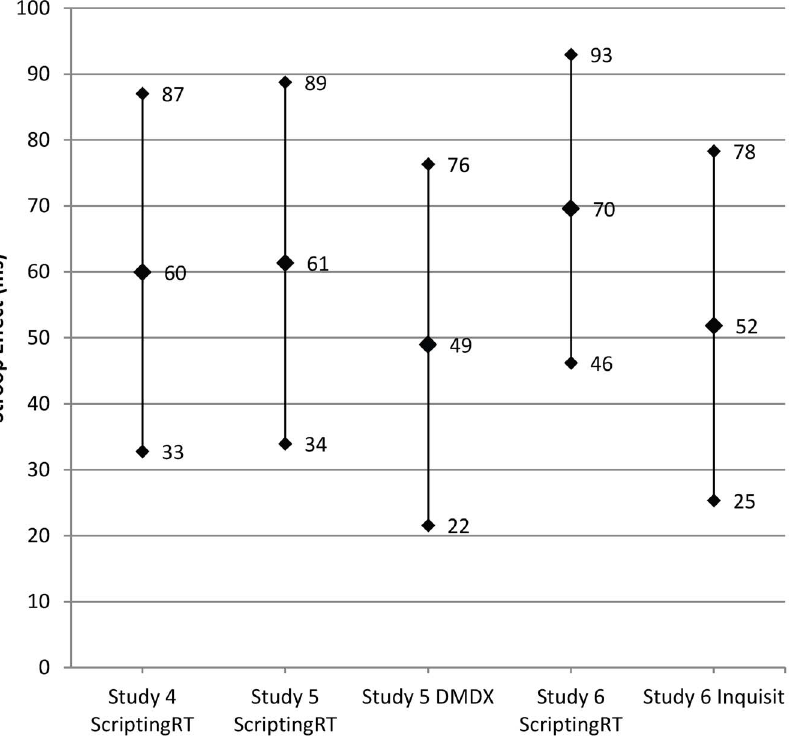
Figure 2. Stroop effects and confidence intervals. Estimated mean Stroop effect (average difference between response latencies in incongruent and congruent trials in ms) and their 95% confidence intervals, obtained in three studies with five samples. Studies 4 and 6 were run online, Study 5 in the laboratory. Software varied within participants in Studies 5, and between participants in Study 6.